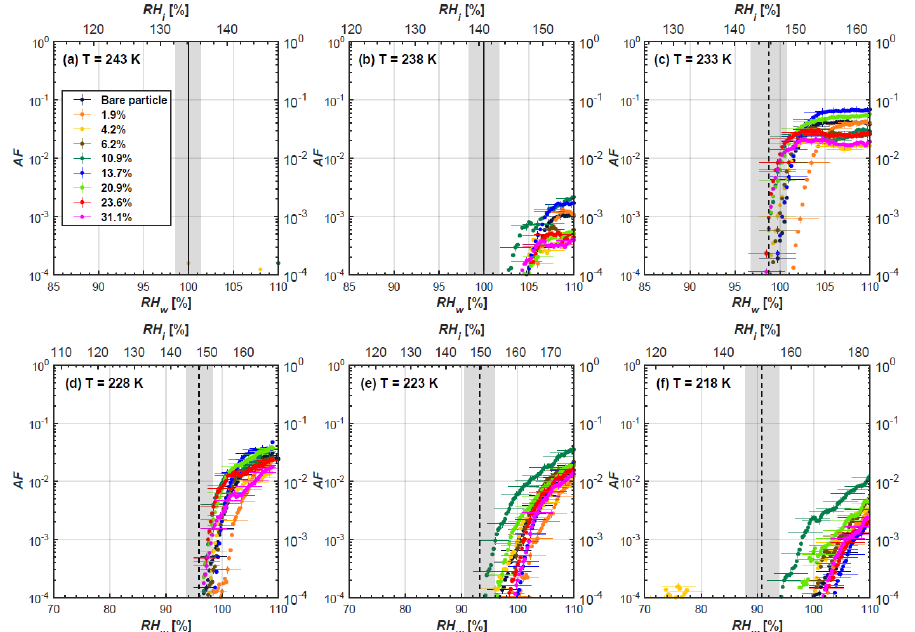
Figure B6. RH scans for bare and coated 400nm mCASTblack soot particles at eight different coating wt% corresponding to the 5µm OPC channel, presented as AF as a function of RH. Black solid lines represent water saturation conditions according to Murphy and Koop (2005). Black dashed lines denote the expected RH values for homogeneous freezing at T < HNT (Koop et al., 2000). The grey-shaded areas show the possible RH uncertainty calculated for water saturation and homogeneous freezing conditions. The percentage number represents the H 2 SO 4 coating mass ratio to the bare particle